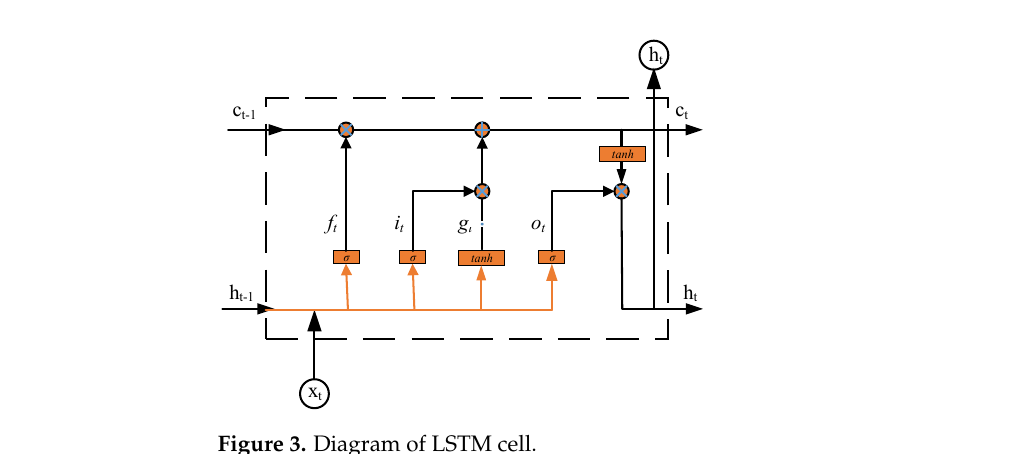
Figure 3. Diagram of LSTM cell.